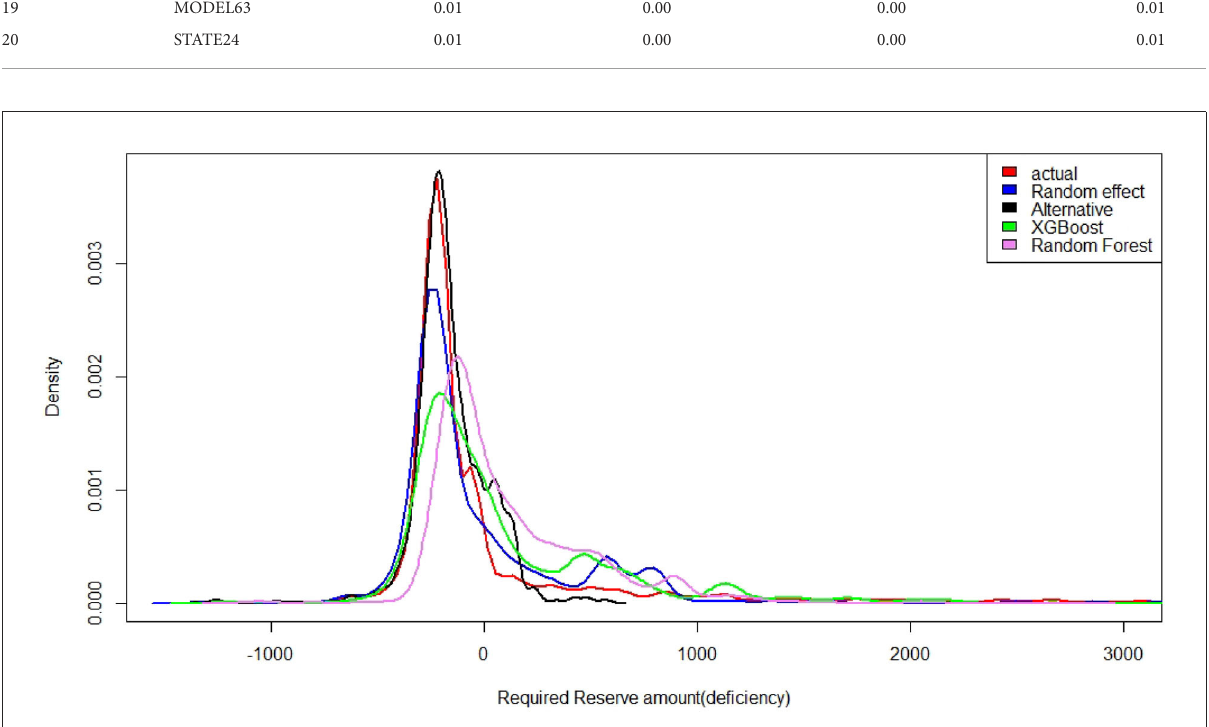
FIGURE4 Reserve amount for the unearned premium risk under each model for test data set.